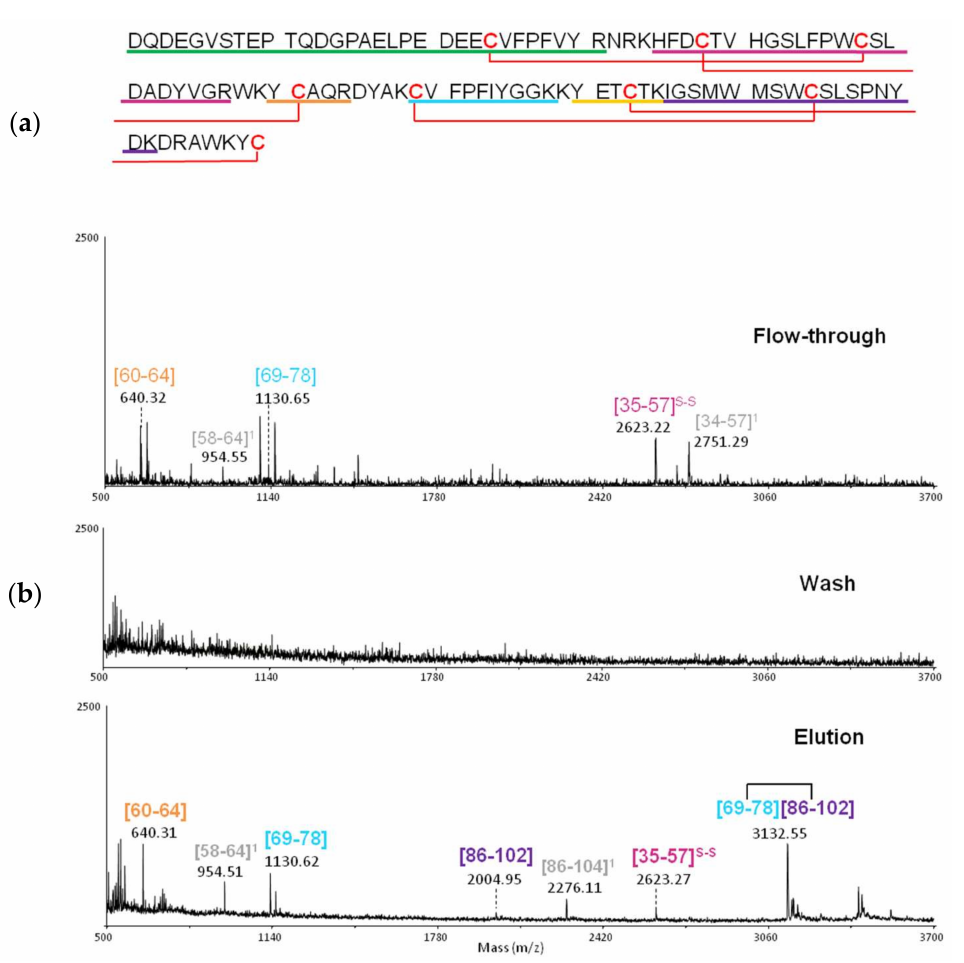
Figure 7. ( a ) PDC-109 sequence; peptide fragments obtained by trypsin digestion in solution are shown in colour; ( b ) MALDI-TOF MS spectra of the different fractions of the PDC-109 vs. Fuc- α 1,4-GlcNAc CREDEX-MS excision